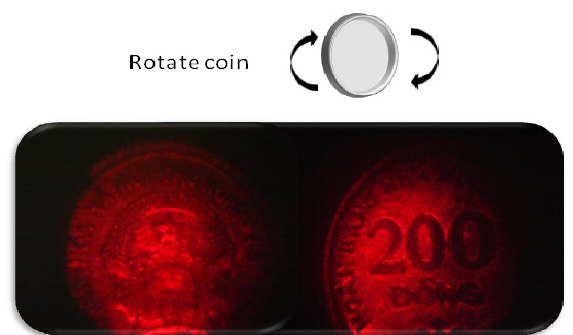
Figure 6. Hologram images of head and tail of